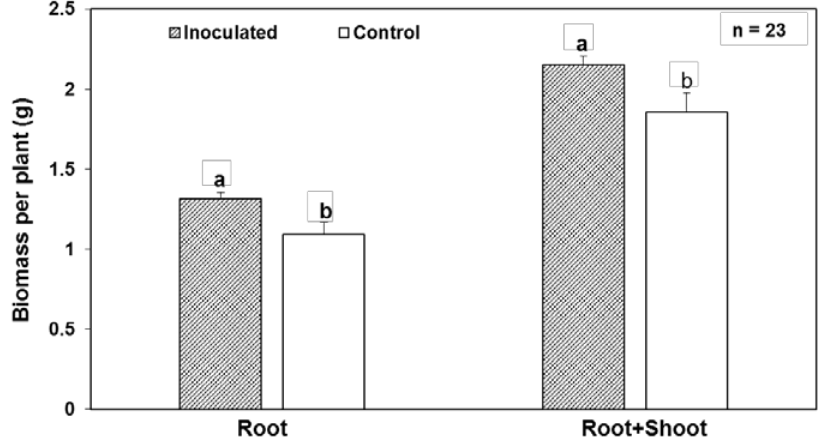
Figure 7. Root, and root and shoot biomass of WP5 gfp inoculated and mock-inoculated control plants in maize hybrid 29B17. Error bars represent standard error of the mean. Histograms with different letters are statistically different at p < 0.05.